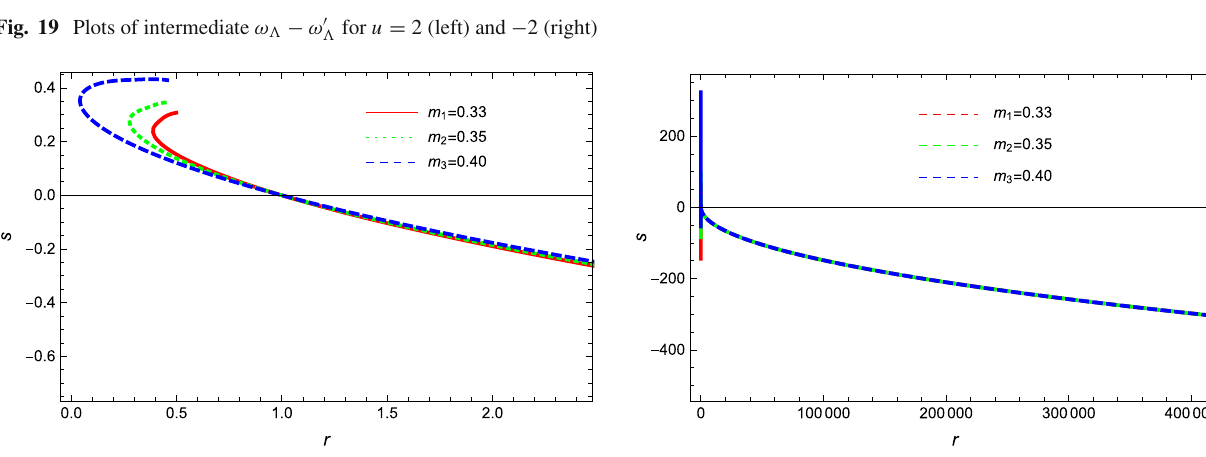
Fig. 20 Plots of intermediate r − s plane for u = 2 (left) and − 2